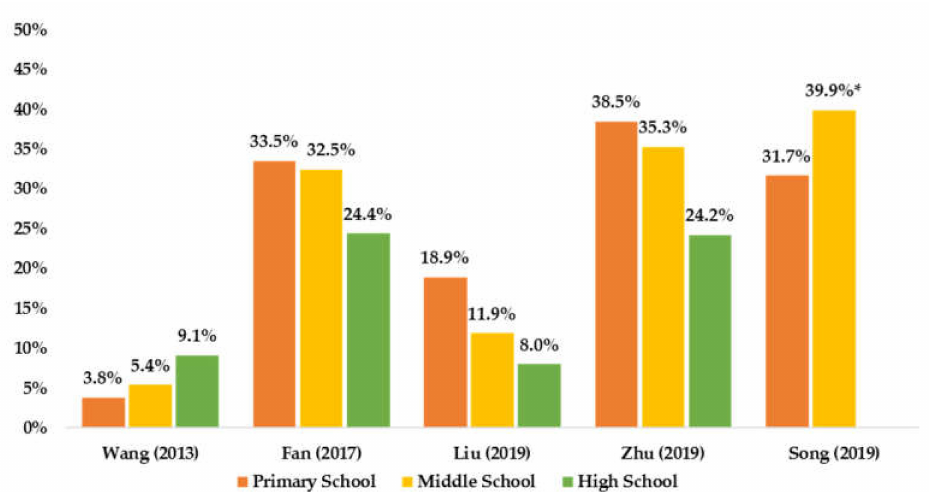
Figure 3. Summarized available PA prevalence by age group among Chinese children and adolescents. * combined middle school and high